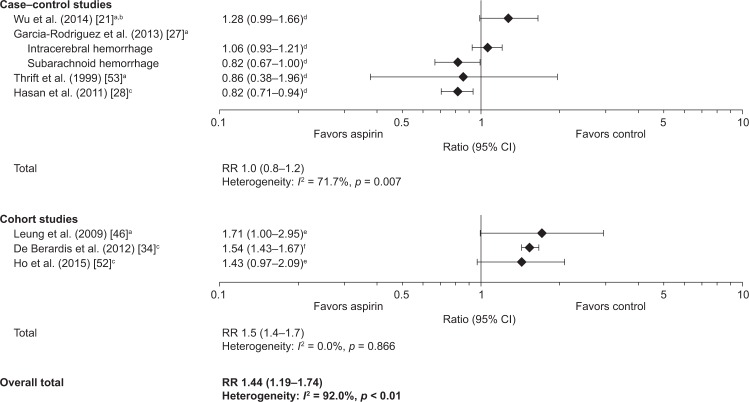
Risk of intracranial (including intracerebral) hemorrhage with low-dose aspirin.Data are shown as adjusted OR, multivariate HR or adjusted IRR, plus 95% CIs, for the risk of intracranial (including intracerebral) hemorrhage with low-dose aspirin vs no aspirin. A test for heterogeneity (I2 statistic) is provided. aIntracerebral hemorrhage/hemorrhagic stroke; bIntracranial hemorrhage; cCase-crossover study; dadjusted OR; emultivariate HR; fadjusted IRR. CI, confidence interval; HR, hazard ratio; ICH, intracerebral hemorrhage; IRR, incidence rate ratio; OR, odds ratio; SAH, subarachnoid hemorrhage.